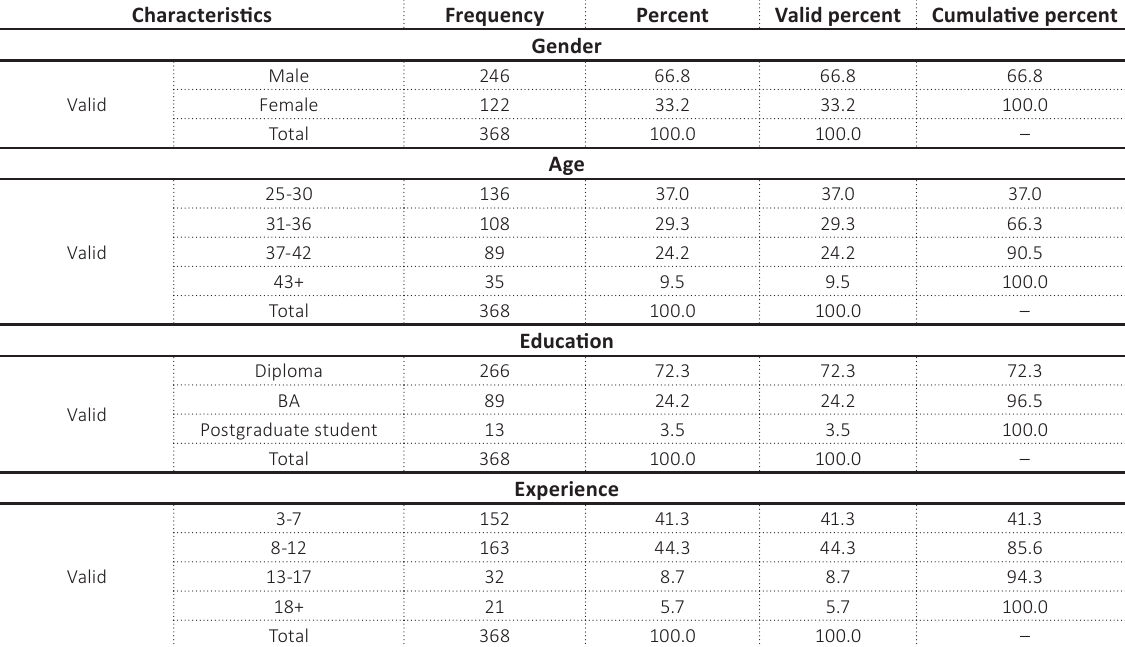
Table 1. Sample characteristics according to demographics Characteristics